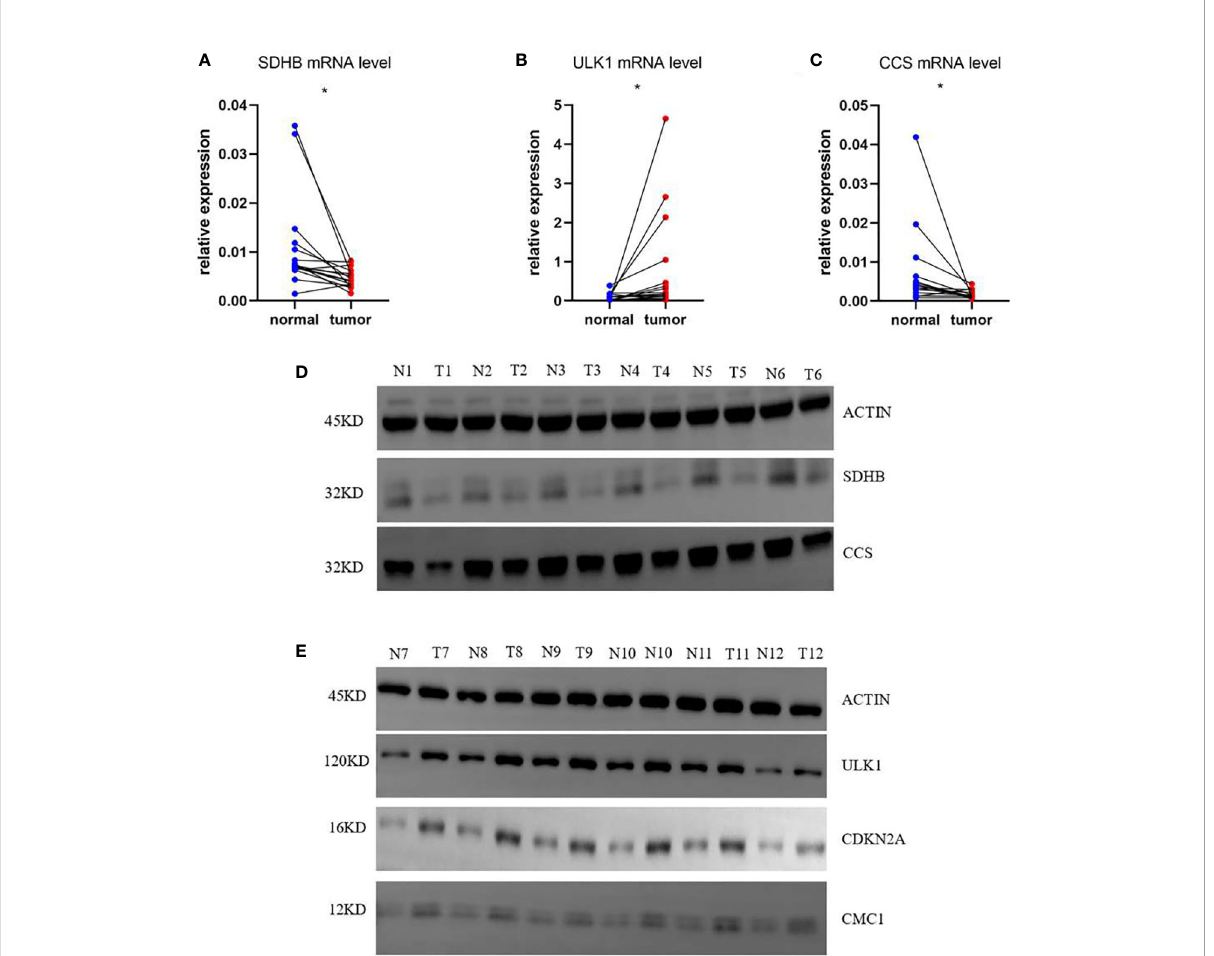
FIGURE 8 mRNA and protein relative expression of genes in the risk model. (A) mRNA relative expression of SDHB; (B) mRNA relative expression of ULK1; (C) mRNA relative expression of CCS; (D) Protein relative expressions of SDHB and CCS; (E) protein relative expressions of ULK1, CDKN2A, and CMC1